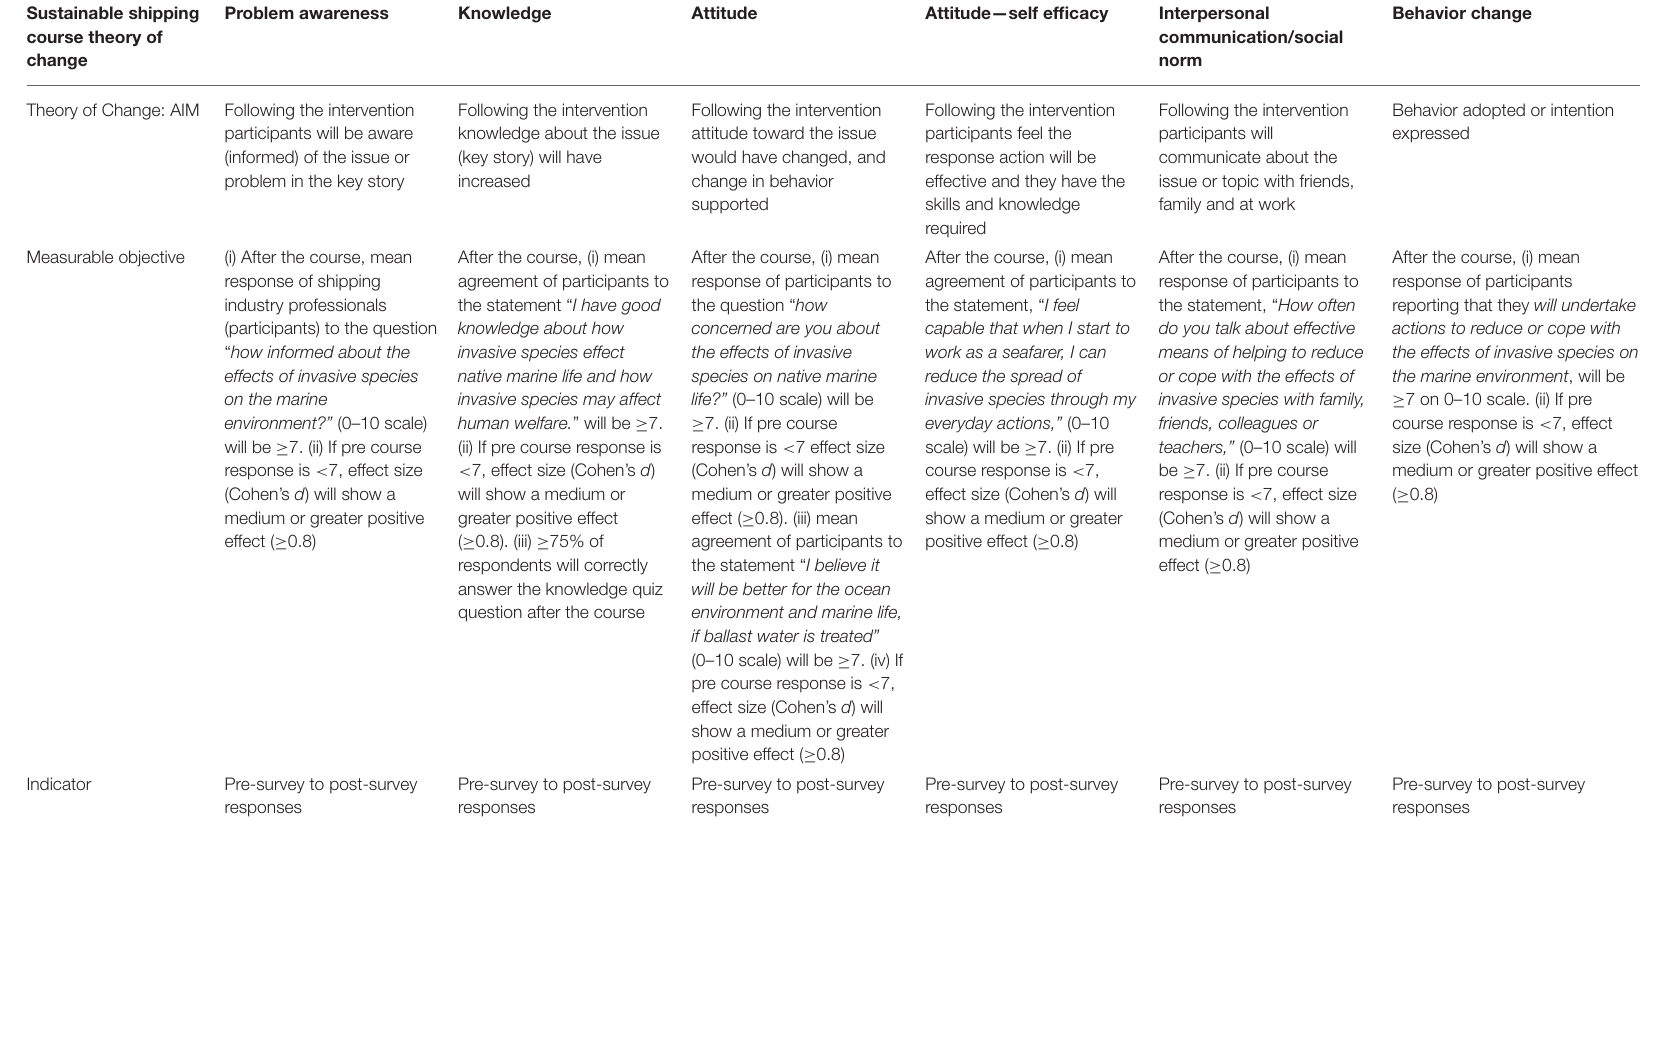
TABLE 3 | Theory of Change model for the “sustainable seafaring” education course for young